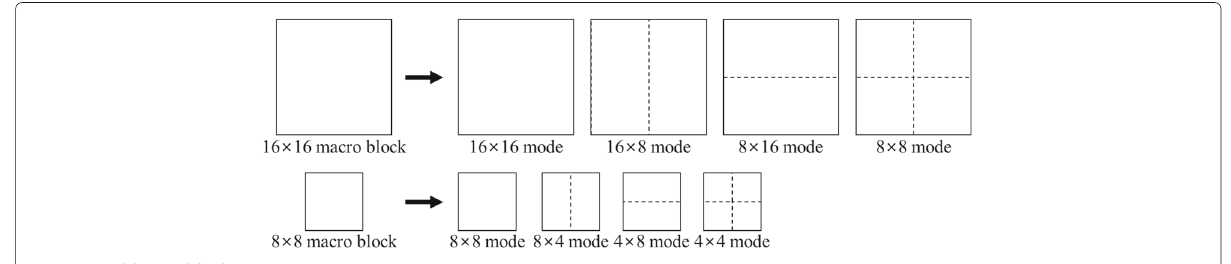
Fig. 9 Variable-size block in H.264/AVC